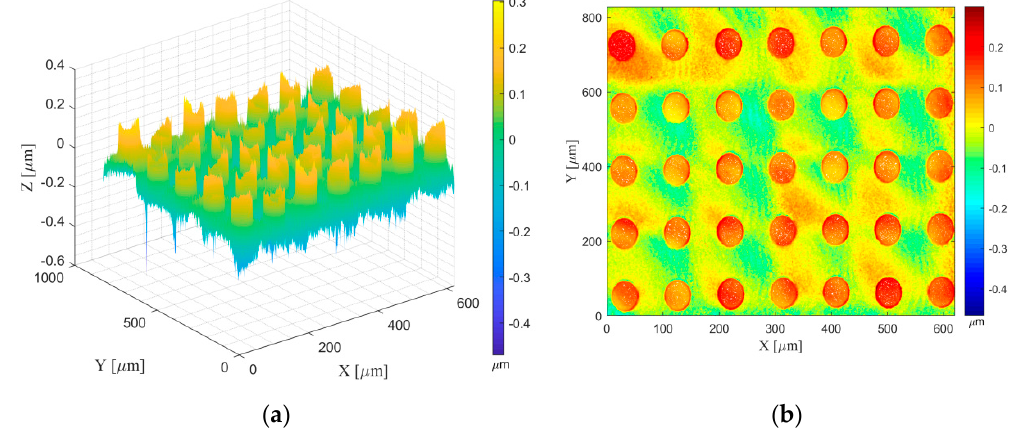
Figure 15. The measured surface with form removed: ( a ) 3D reconstruction and ( b ) 2D reconstruction.